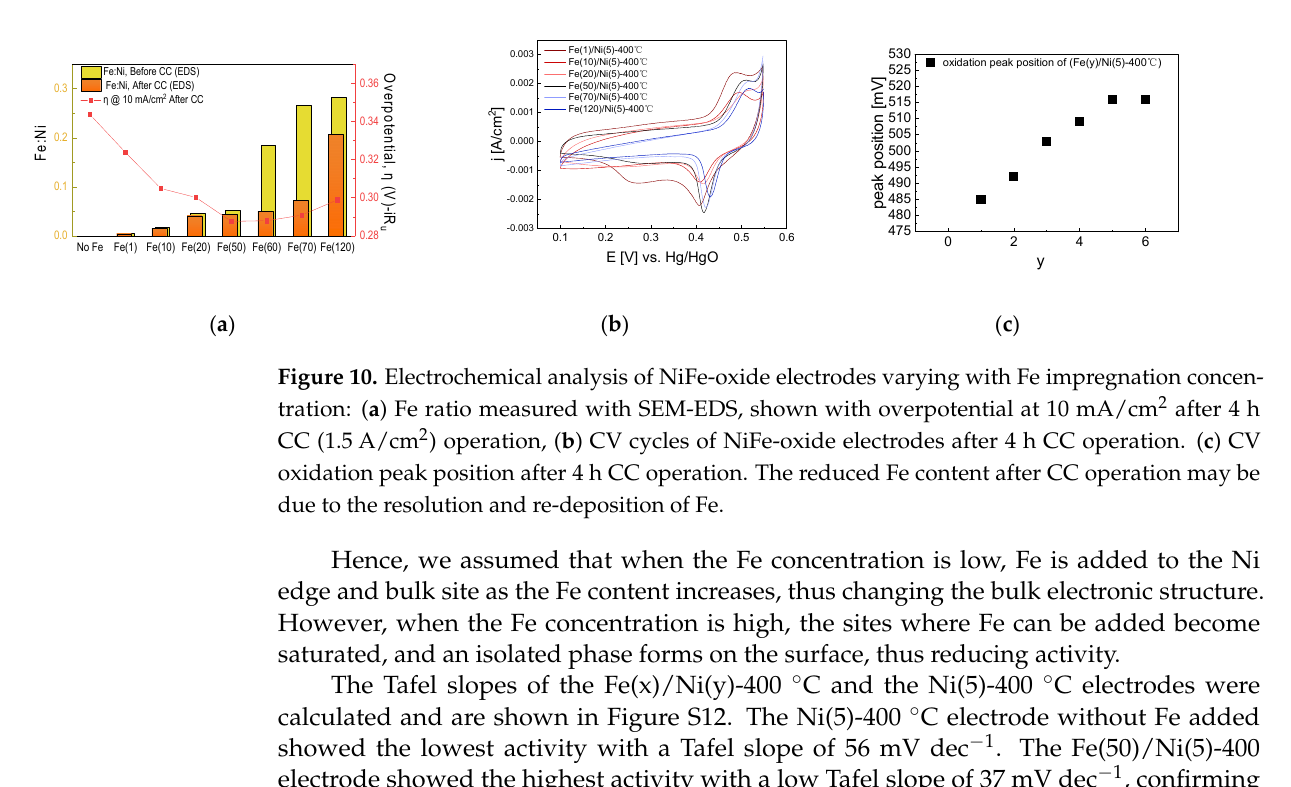
13 of 20 activity after a total 4 h CC operation was used to compare the activity and electrochemical analysis results of the NiFe-oxide electrodes prepared under various synthesis conditions. The Fe(50)/Ni(x)-400 °C electrode prepared by heat treatment at 400 °C was analyzed via SEM to measure the thickness and OER activity, as shown in Figure 9. As the Ni coat- ing solution concentration increased, the thickness of the coating layer increased, and the activity increased and then decreased. The OER activity was the highest at η = 0.287 V for the Fe(50)/Ni(5)-400 °C electrode, at which the catalyst layer thickness was 9.02 μ m. Furthermore, the CV graph in Figure 9 demonstrates that as the Ni coating layer con- centration increased, the oxidation peak shifted to a positive potential, indicating the in- creased Fe content. The Ni solution concentration might affect the increase in the Fe con- tent during the impregnation process; more Fe can be accommodated as the porous Ni(OH) 2 coating layer becomes thicker with the increasing Ni concentration. However, the activity decreased once the coating-layer thickness exceeded a certain level. This is presumed to be because the effect of the thick coating layer impeding mass transfer is greater than the effect of increasing the activity by increasing the Fe content. ( a ) ( b ) ( c ) Figure 9. Electrochemical analysis of NiFe-oxide electrodes varying with respect to Ni coating con- centration: ( a ) Thickness of NiFe-oxide layers shown with overpotential at 10 mA/cm 2 after 4 h CC (1.5 A/cm 2 ) operation, ( b ) CV cycles of NiFe-oxide electrodes after 4 h CC operation and ( c ) CV oxidation peak position after 4 h CC operation. Because the thickness is uneven, thickness at three different points was measured and averaged.